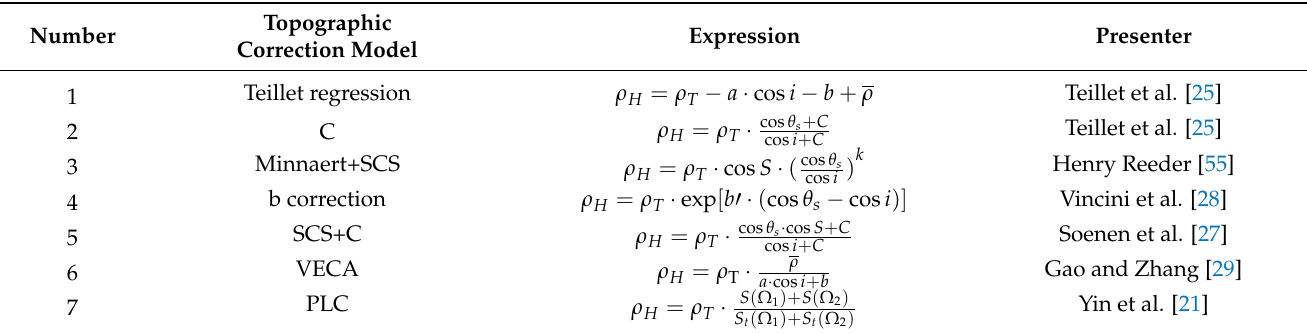
Table 1. The topographic correction methods used in this